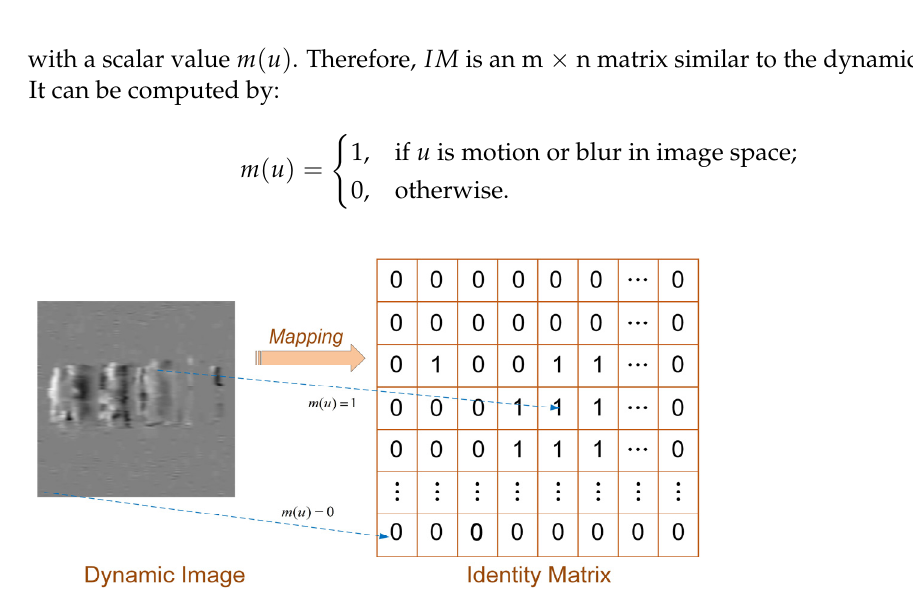
Figure 3. The dynamic image and identity matrix are on the left and the right, respectively.